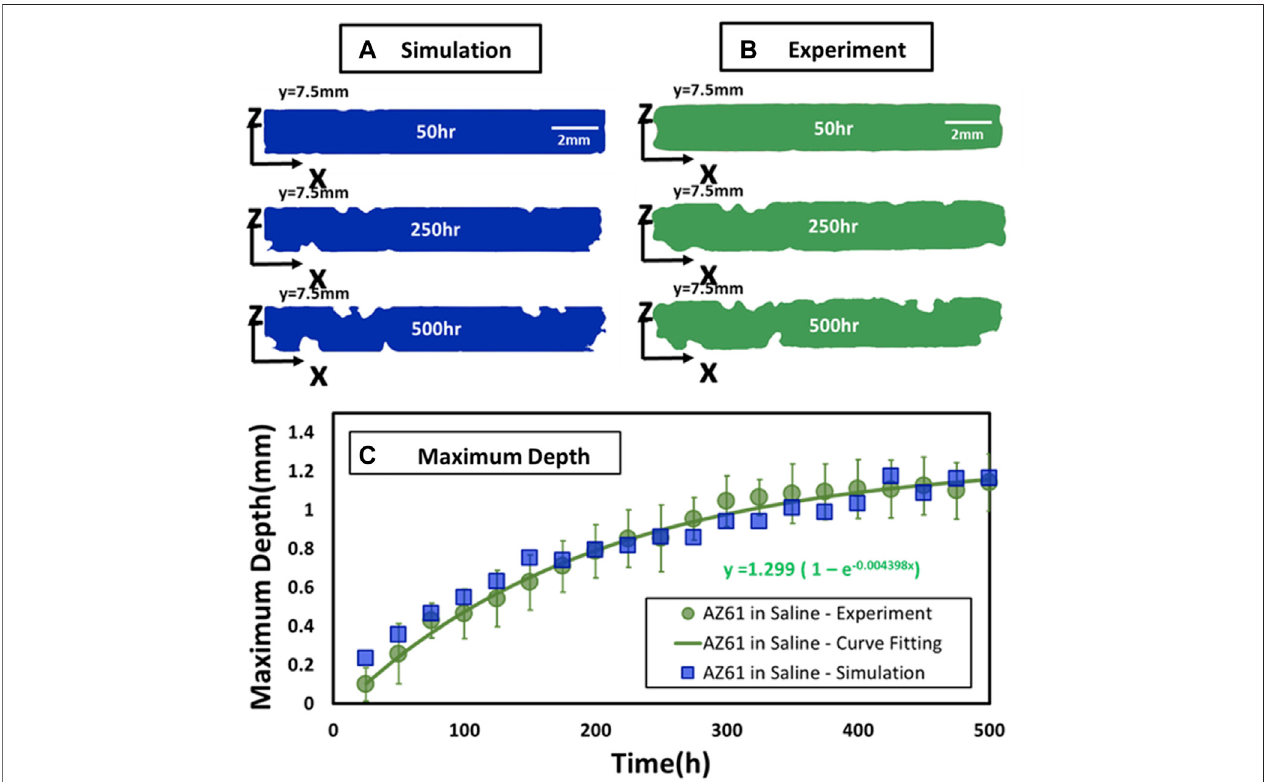
FIGURE 2 | Comparison of experimental and simulated perpendicular cross sections. (A,B) Comparison of experimental and simulated corrosion patterns across three parallel cross sections at y = 7.5 mm at T = 50, 250, and 500 h. (C) Maximum depth of specimen at different corrosion times.